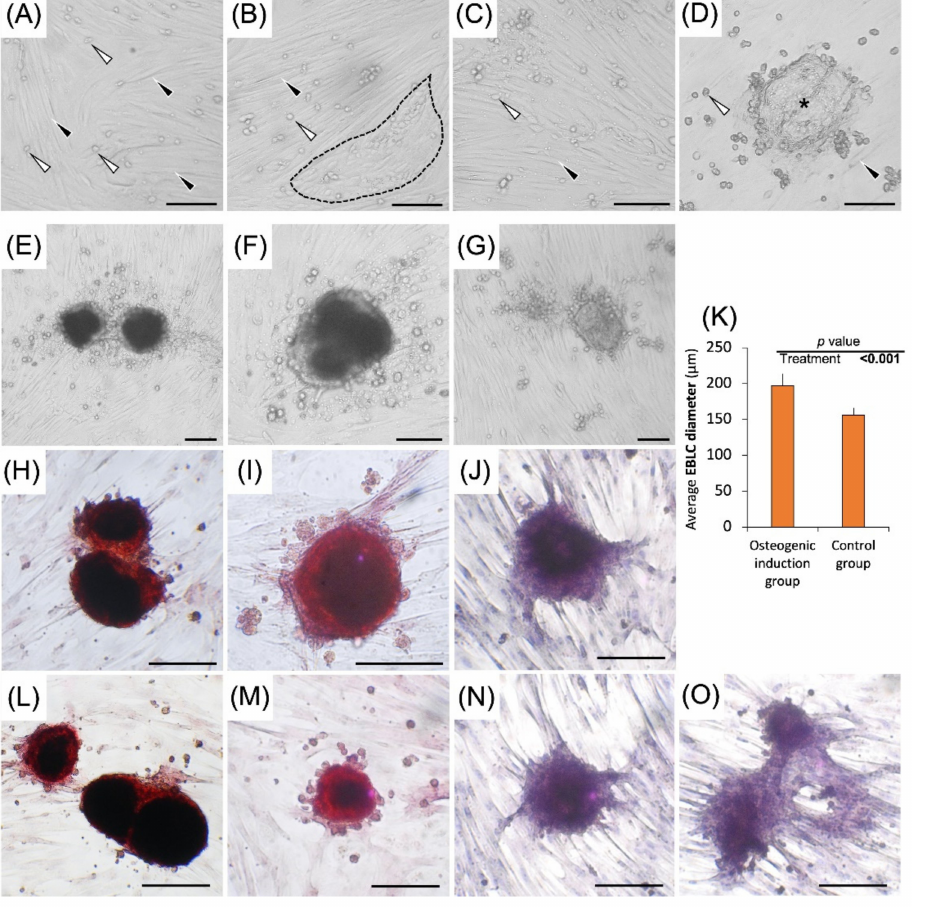
Figure 2. Representative photomicrographs of culture wells in regular media and osteogenic differ- entiation media, as well as the average diameter of EBLCs in different groups. When cultured in regular media, by day 7, somatic cells of the testis formed a complete monolayer attached to the culture well (black arrowhead). Gonocytes were located on top of the spindle-shaped somatic cells (white arrowhead) ( A ). By day 14, somatic cells formed circular arrangements (black broken line) ( B ). In circular arrangements, gonocytes were surrounded by cytoplasmic projections of somatic cells. Gonocytes gradually increased in number by undergoing proliferation. Also, by day 14, convergence of surround- ing gonocytes in circular arrangements led to formation of large multinucleated embryoid body-like colonies (EBLCs). By day 28, gonocytes increased in number and EBLCs became larger (black asterisk) ( C , D ). EBLCs in osteogenic differentiation group ( E , F , H , I , L , M ) possessed a more compact appearance compared to those developed in control groups ( G , J , N , O ). Also, EBLCs in osteogenic